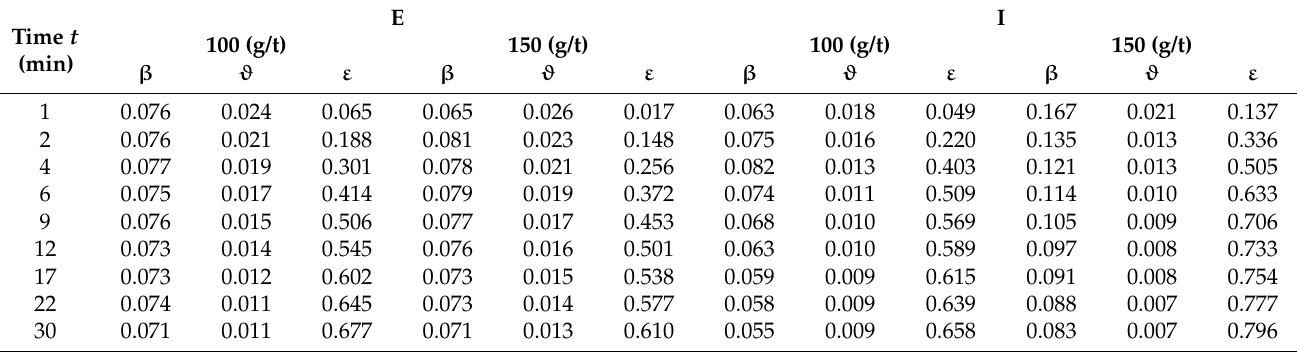
Table 4. Results of measurements for particle size fraction 20–40 ( µ